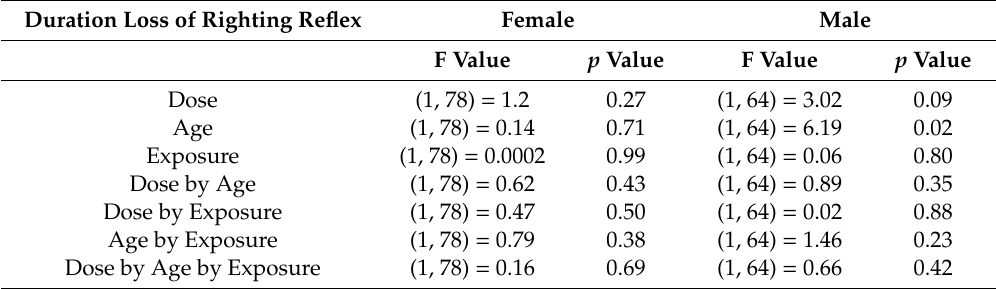
Table 9. Table for ANOVA results for blood ethanol concentration time course analysis data.